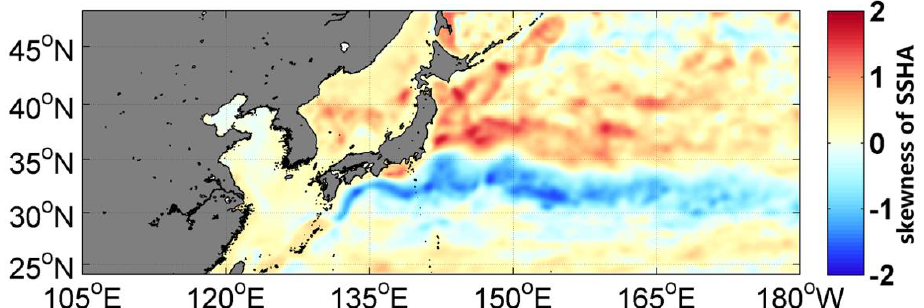
Figure 9. Spatial distribution of the skewness of the probability density distribution of SSHA (1998– 2012) in the Kuroshio Extension region.